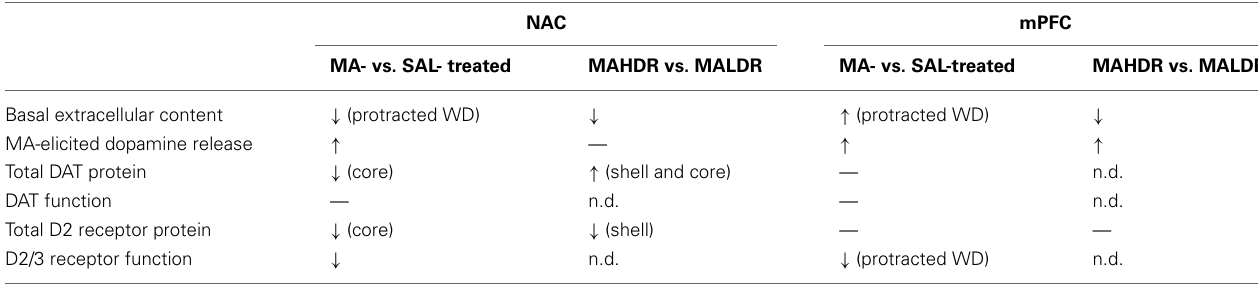
Table 4 | Comparison of the dopamine effects of subchronic, subtoxic methamphetamine (MA) vs. saline (SAL) treatment and the dopamine phenotype of MA-naïve MAHDR vs. MALDR